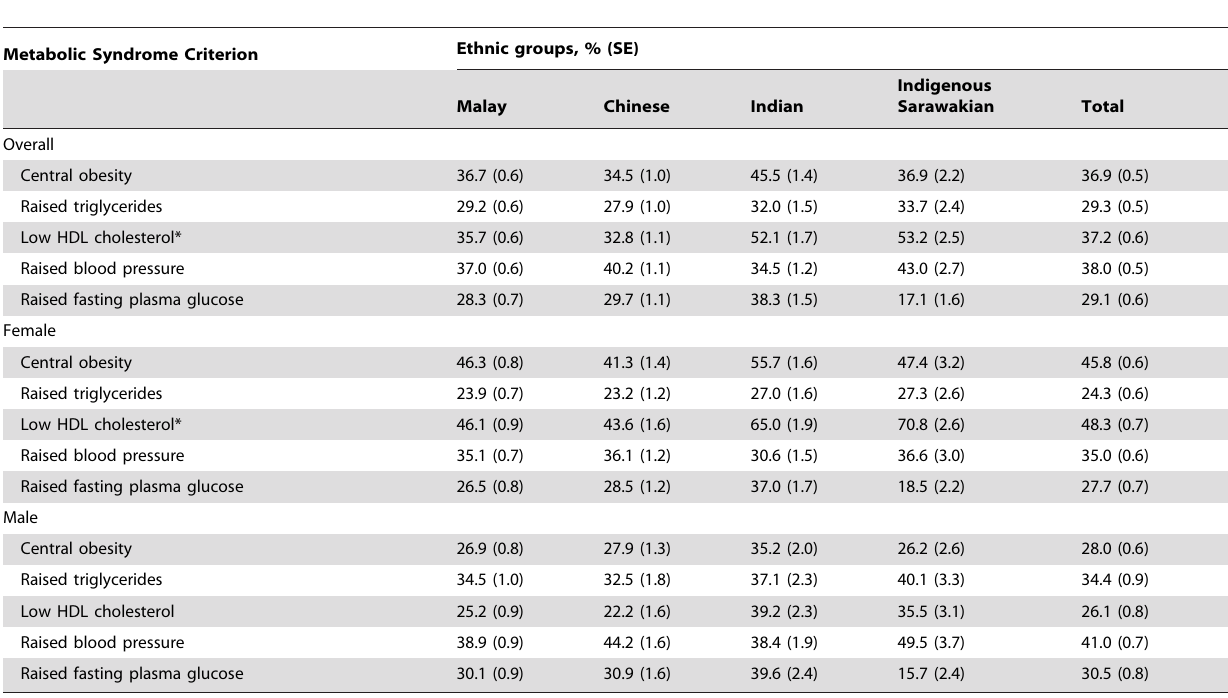
Table 4. Prevalence of metabolic syndrome criteria by gender and ethnicity among Malaysians $ 15 years, 2004.